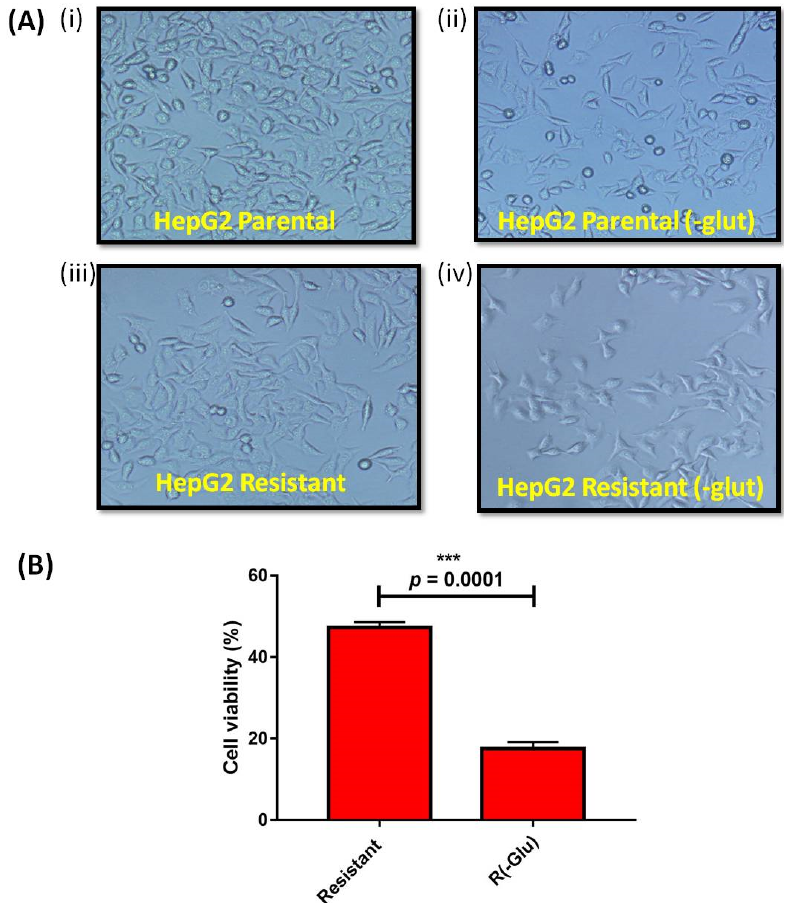
Figure 4. MTT assay showing cell viability ( A ) Morphological analysis ( B ) Bar graph representation of cell viability percentage in Resistant: sorafenib resistant HepG2 cells; R(-glut): sorafenib resistant HepG2 cells without exogenous glutamine (*** p ≤ 0.001) .